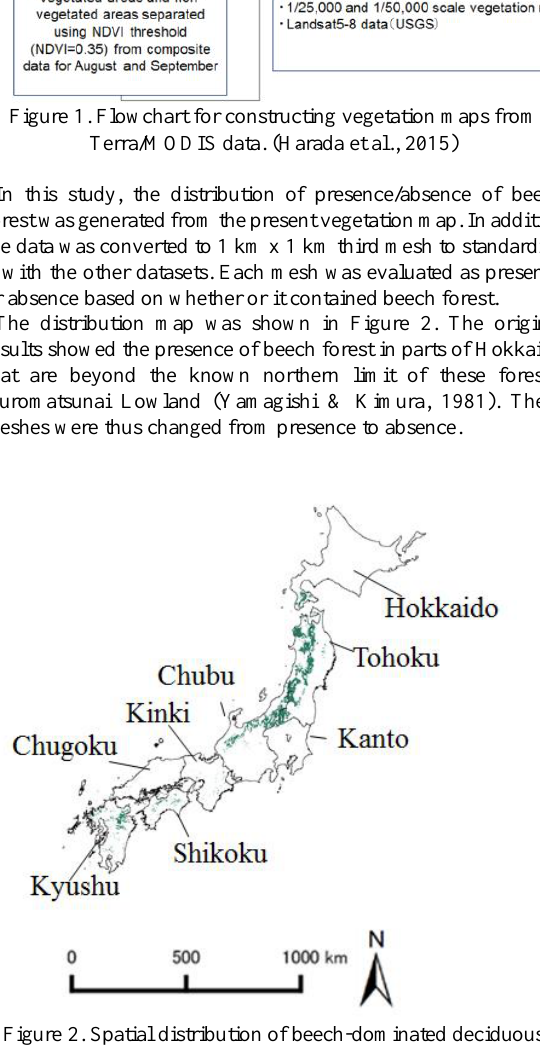
Figure 2. Spatial distribution of beech-dominated deciduous forests derived from the present vegetation map.